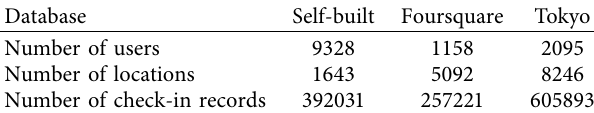
Table 1: Recommended data set of tourism series.